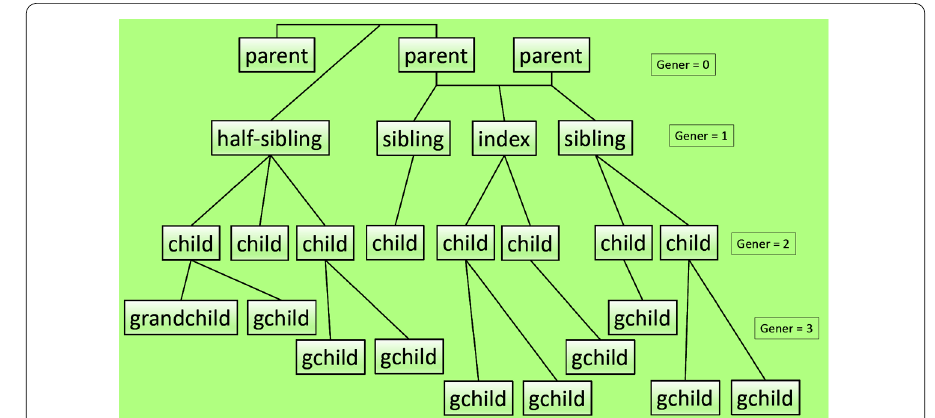
Figure 1 A typical genealogical network in the dataset for a single extended family. The structure of an extended family is shown and it consists of the four generations: the zeroth generation comprising of the parents and a step-parent of the index person; the first generation comprising of the index person and his or her siblings and half-siblings; the second generation comprising of the children; and the third generation comprising of the grandchildren